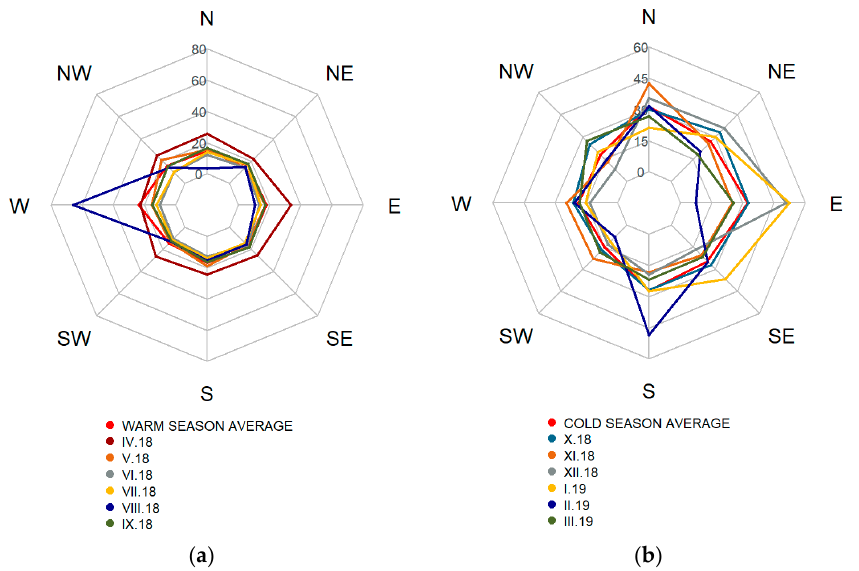
Figure 6. The monthly average PM 10 concentrations for warm ( a ) and cold ( b ) season.